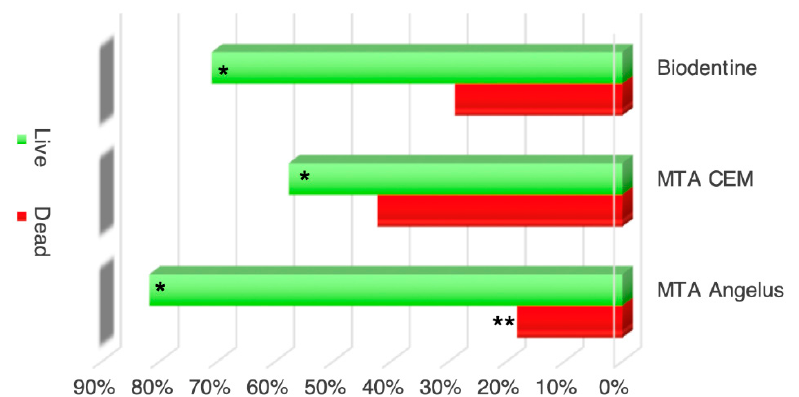
Figure 3. The average percentages of live ( Green ) and dead bacteria ( Red ). The average bacterial contamination (stained areas) of live and dead bacteria in all locations tested combined (buccal, lingual, mesial, and distal). * Significantly more live bacteria were seen in Groups 1–3. ** The ratio of live to dead bacteria was significantly higher in the MTA-Angelus group (Group 1) than in the other groups ( p =